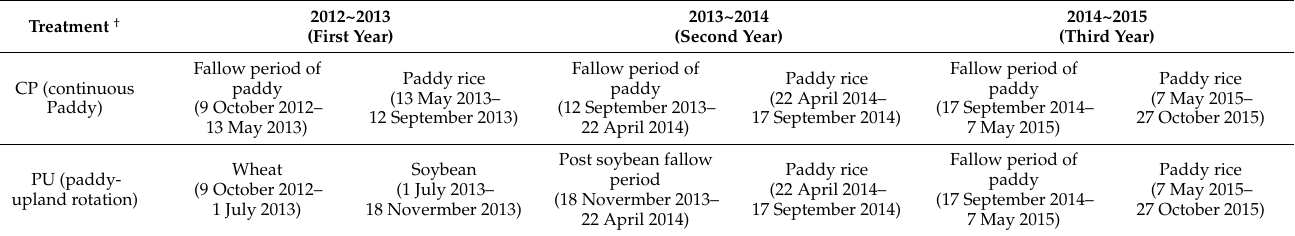
Table 1. Setting of the experimental plots.